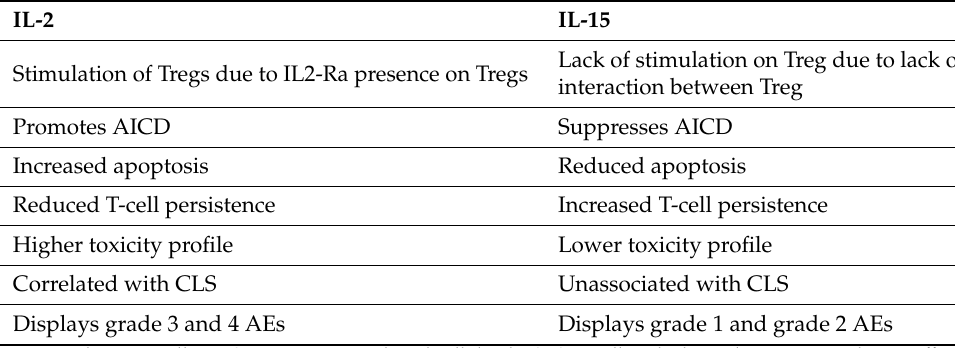
Table 2. Comparison of IL-15 and IL-2 in